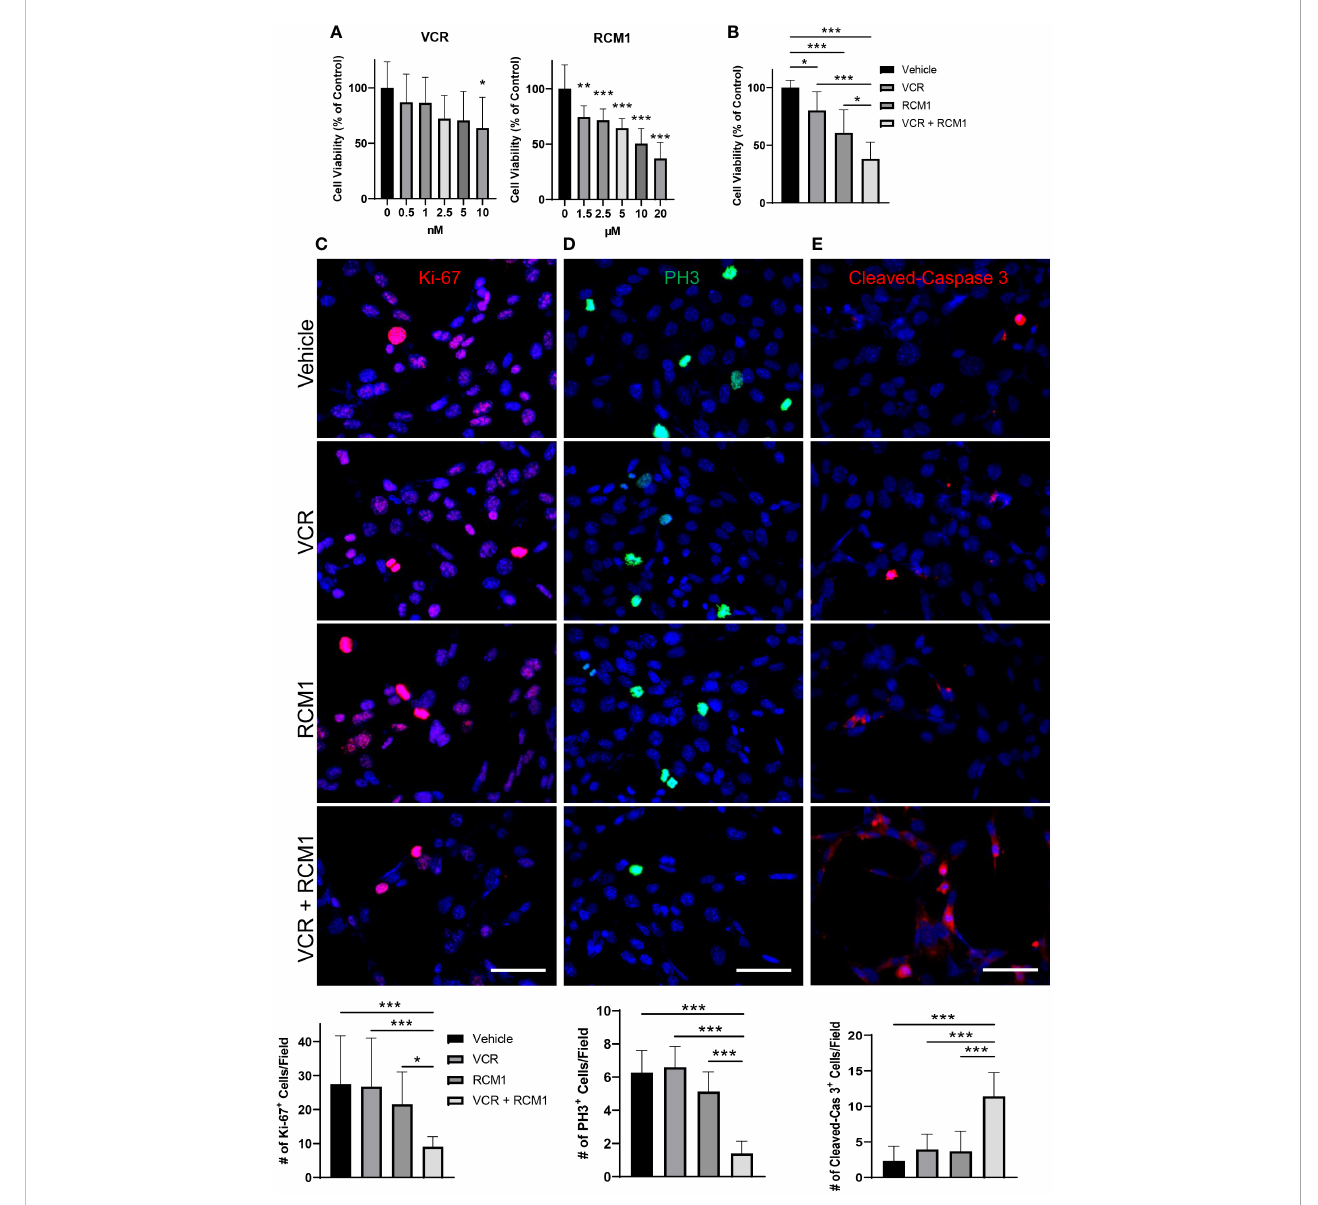
FIGURE 1 Combination of VCR and RCM1 is more ef fi cient than single agents in reducing growth of murine Rd76-9 rhabdomyosarcoma cells in vitro. (A) , Left: Vincristine (VCR) reduced Rd76-9 tumor cell viability in a dose-dependent manner after 24 hours of treatment compared to vehicle (saline) control. Right: RCM1 reduced Rd76-9 tumor cell viability in a dose-dependent manner after 24 hours of treatment compared to vehicle (DMSO) control. Graphs show the percentage of live tumor cells per group compared to vehicle control. (B) , Combination therapy using IC 50 concentrations of VCR (2.1nM) and RCM1 (8.7µM) reduced Rd76-9 tumor cell viability compared to single agents at IC 50 concentrations and to vehicle (saline + DMSO). The graph shows the percentage of live tumor cells per group compared to vehicle control after 24 hours of treatment. (C) , Combination therapy decreased Rd76-9 tumor cell proliferation (Ki-67, red) and mitosis ( D , PH3, green), and increased apoptosis ( E , Cleaved-Caspase 3, red) compared to single agents or vehicle control after 24 hours of treatment. 5 random fi elds per sample were used to quantify the number of Ki-67 + , PH3 + and Cleaved-Caspase 3 + cells per group. Values are shown as mean ± SD. * P <0.05; ** P <0.01; *** P <0.001. Scale